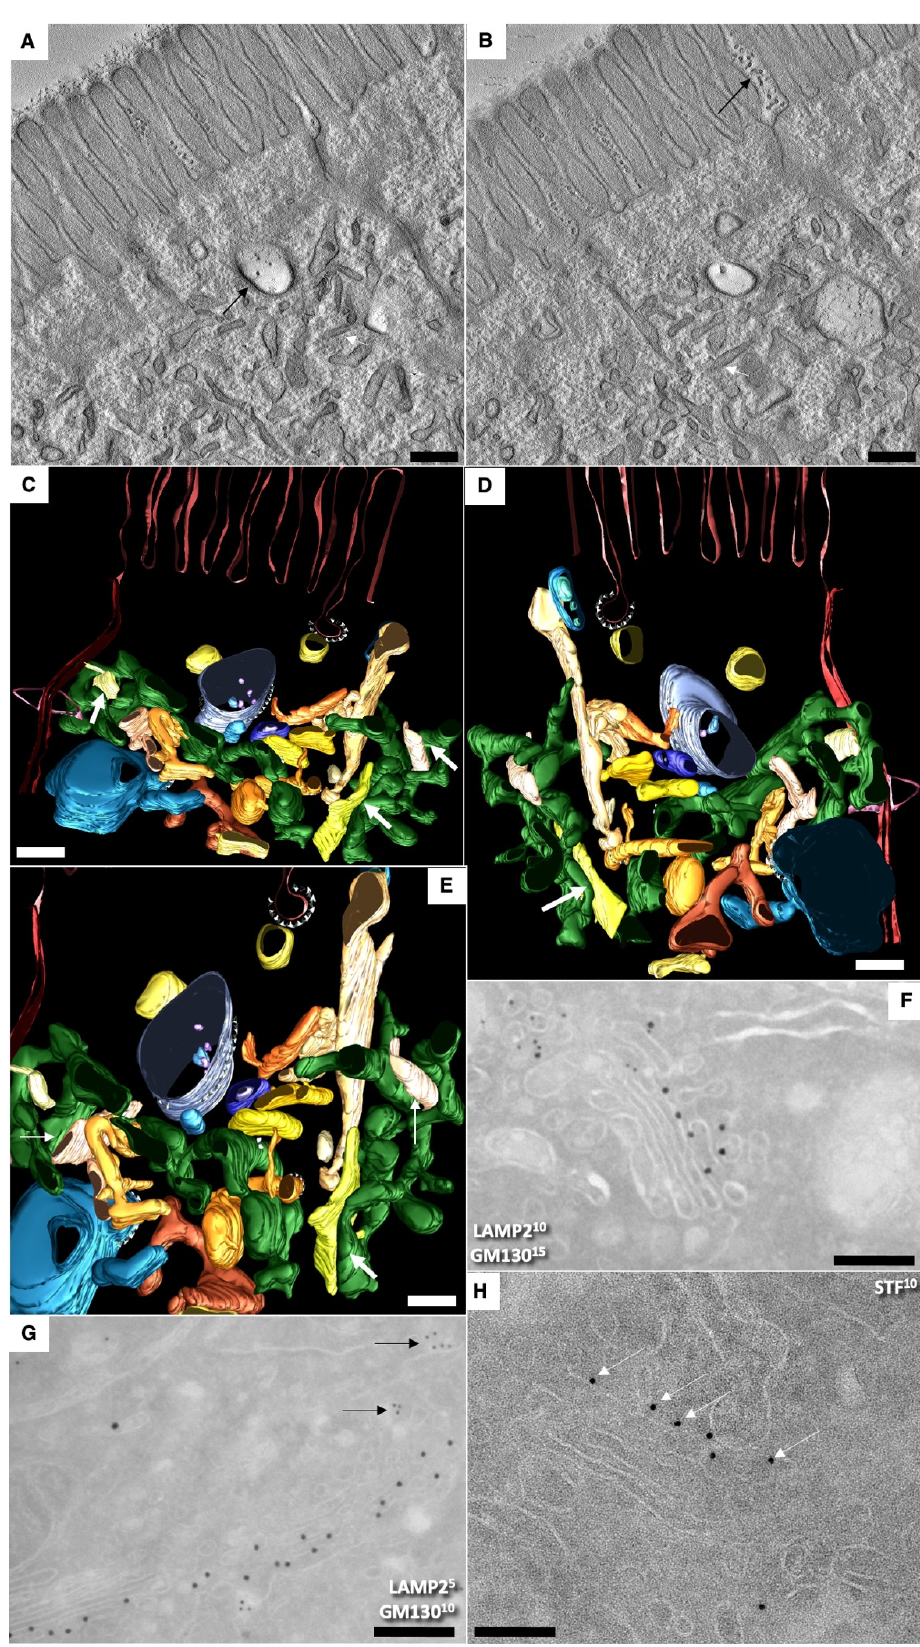
Figure 2. Structure of enterocytes in newborn rats before their first feeding. ( A – F ) Subapical membranous tubular network (white arrows). Black arrows indicate membrane remnants between